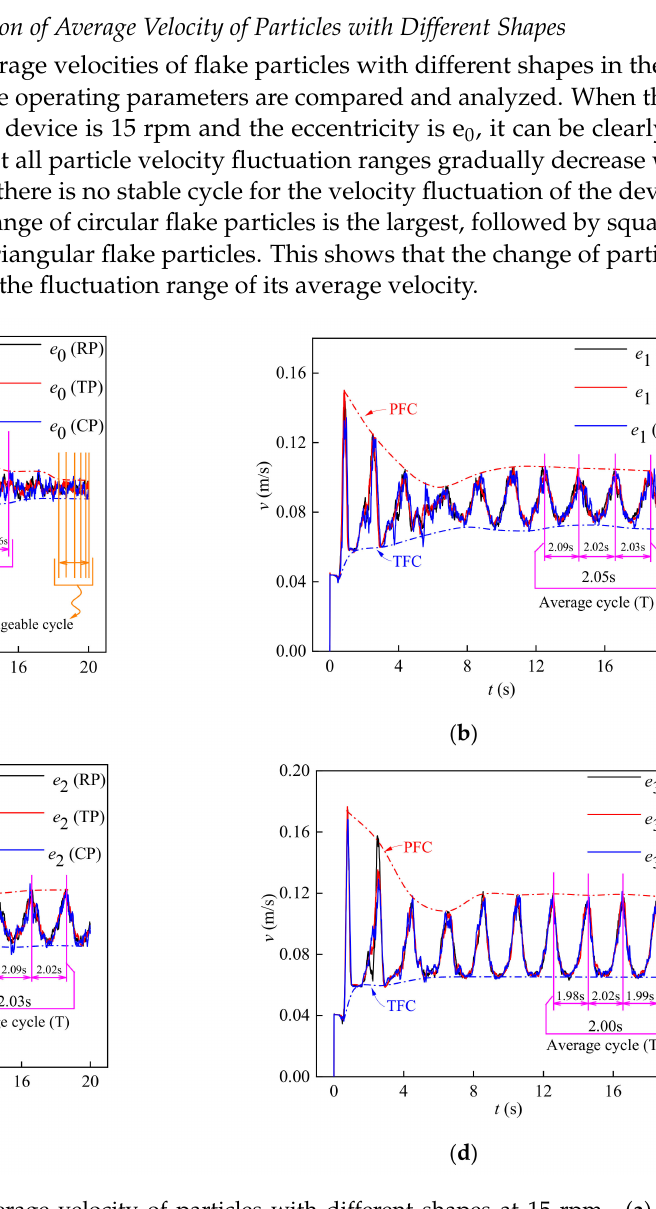
Figure 8. Average velocity of particles with different shapes at 15 rpm. ( a ) Eccentricity of e 0 ; ( b ) eccentricity of e 1 ; ( c ) eccentricity of e 2 ; ( d ) eccentricity of e 3